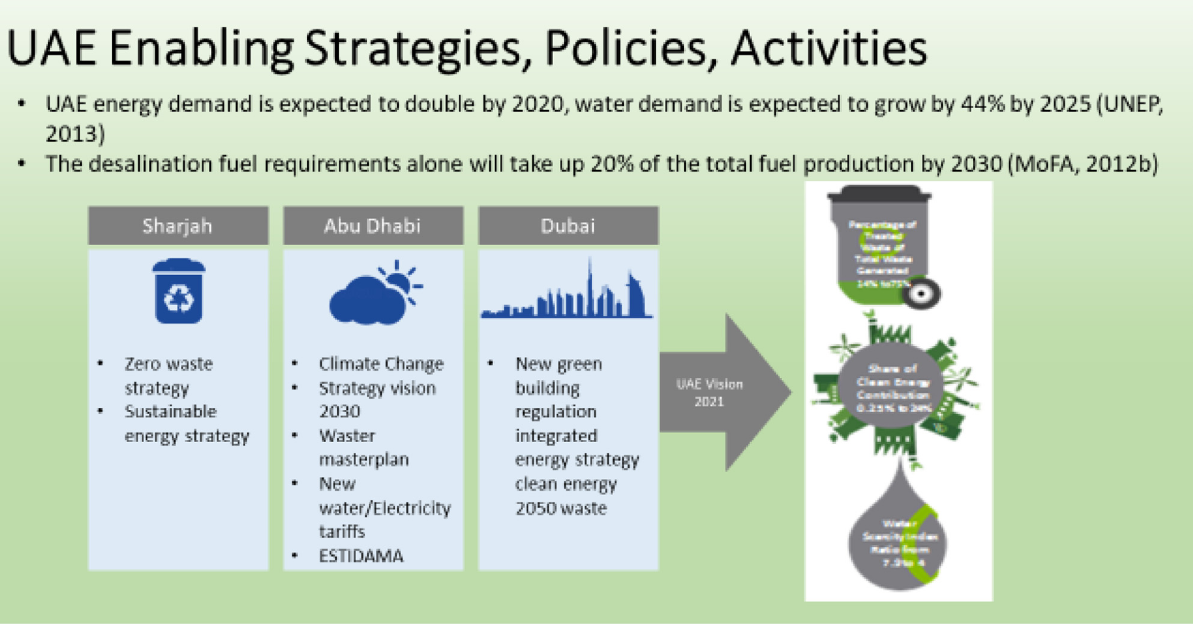
Fig. 11. Water demand growth